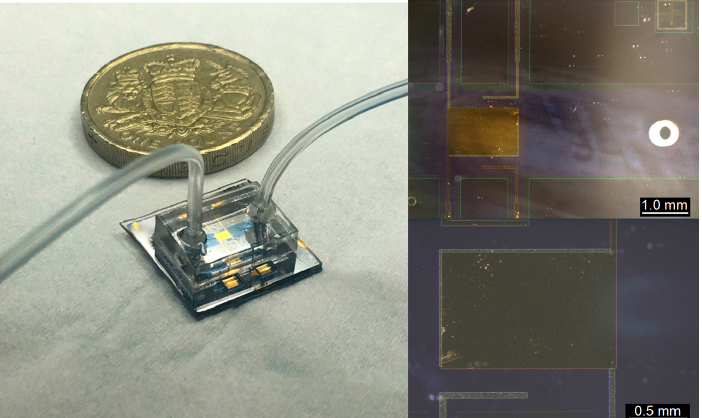
Figure 8. Left: Photograph showing a completed device with PMMA microfluidic interface block, pound coin for scale. Top right: Microscope image showing the overlapping sensing electrodes and auxiliary electrodes with a laser micromachined microfluidic hole centred vertically in the channel. Bottom right: Close-up microscope image showing misalignment of the two central electrodes.